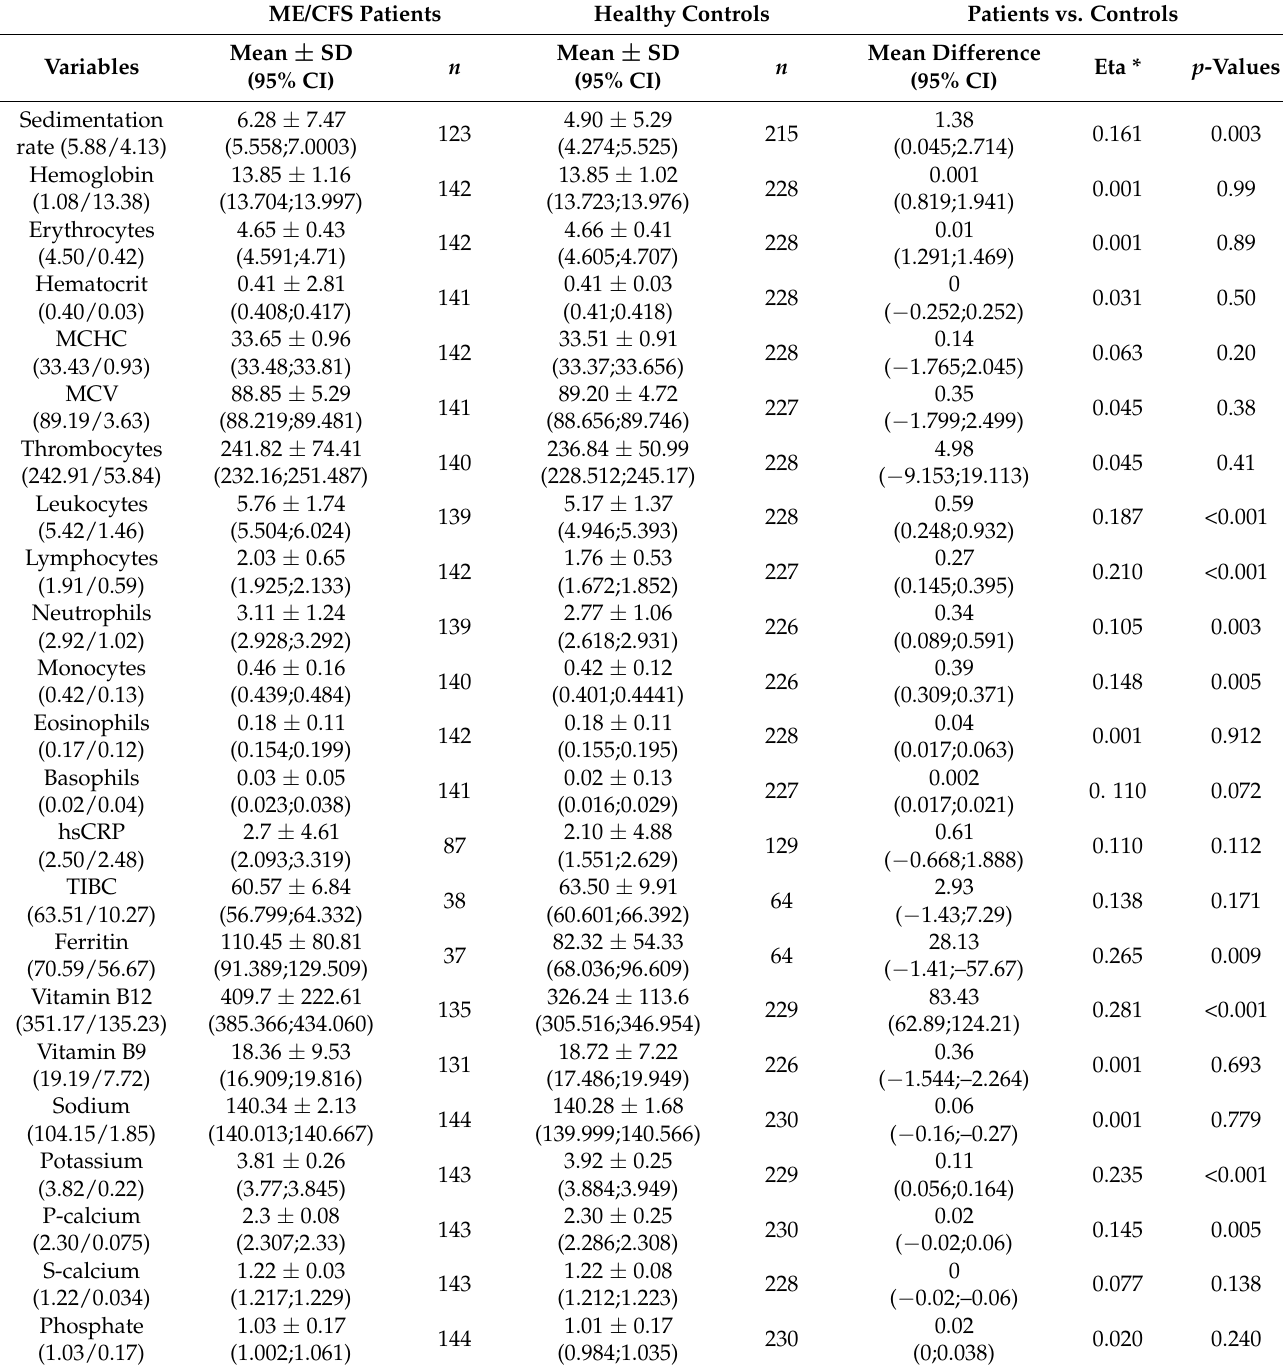
Table 2. Mean scores for routine blood tests in patients with ME/CFS and healthy controls. ME/CFS Patients Healthy Controls Patients vs.